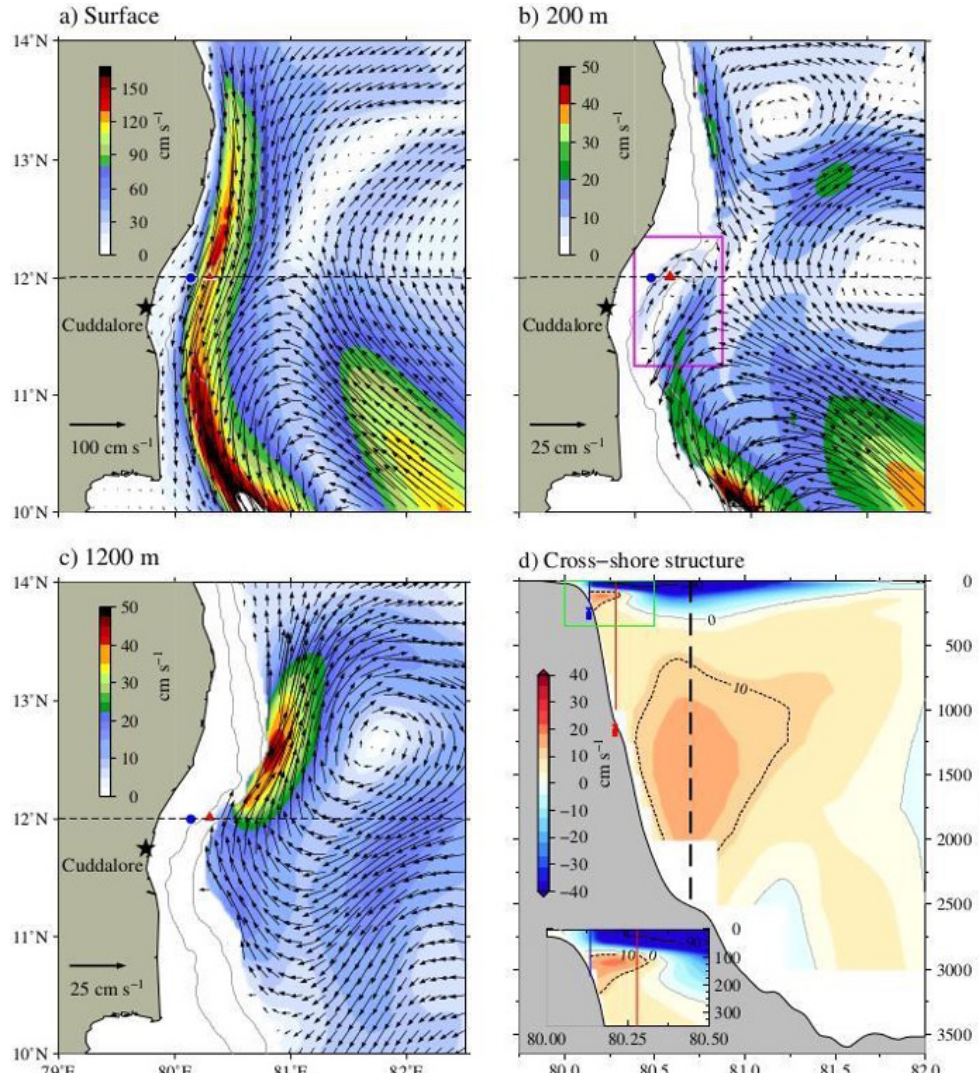
Figure 14. Circulation pattern in the southwestern Bay of Bengal at (a) surface, (b) 200m, and (c) 1200m on 15 November 2014. Vectors show the current direction, and overlaid is the current magnitude (cms − 1 ). Note that the scales of current vectors and colour bars are different for each subplot. The blue circle (red triangle) represents the location of ADCP deployed on the shelf (slope) off Cuddalore. The dashed black line represents the 12 ◦ N latitude. The continuous grey lines represent the 100 and 1000m bathymetric contours. The rectangular box (magenta) indicates the subsurface eddy near the shelf break. (d) Cross-shore structure of alongshore currents across 12 ◦ N. The dashed vertical black line shows the core of the undercurrent, and the red (blue) vertical lines show the location of ADCP mooring on the slope (shelf). The inset plot is the zoomed view of shelf break region indicated by a green box (reproduced from Francis et al.,